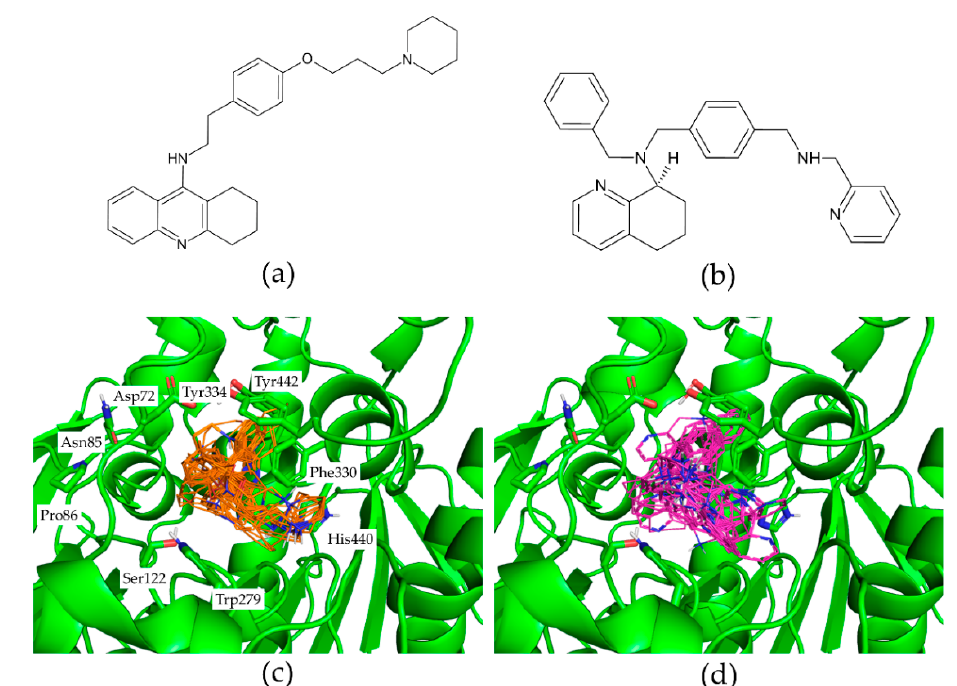
Figure 2. The representative of the active compound ChEMBL15056 ( a ) and the decoy compound C49071124 ( b ). The representative docking results of ChEMBL15056 (carbon atoms are in orange) and C49071124 (carbon atoms are in magenta) in the AChE binding pocket are presented in ( c ) and ( d ), respectively. Figures ( c ) and ( d ) were prepared by employing PyMOL version 2.5.2 (https://pymol.org/2/; accessed on 23 May 2022).